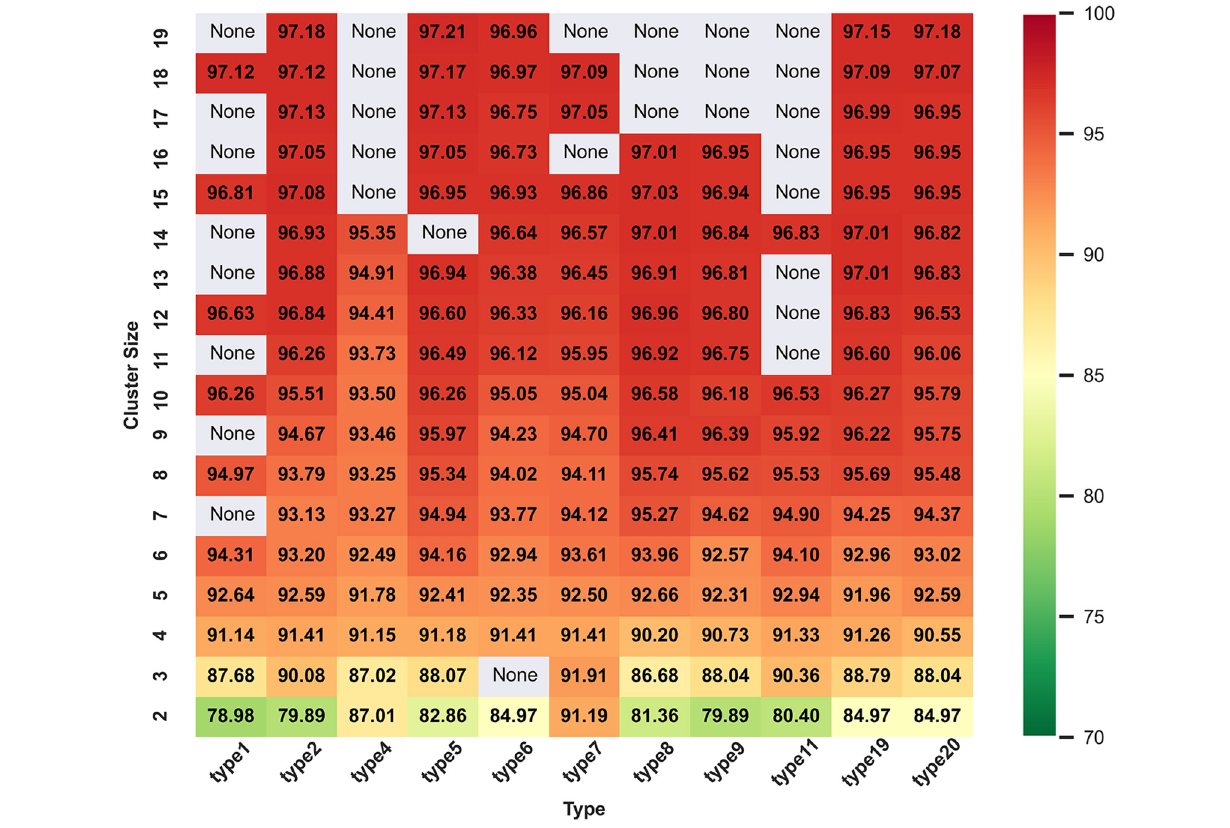
FIGURE 2 | Heat map of ACC values with reduced types from 1 to 20 and cluster size of 2 to 19 on training dataset in DS1. In general, the color gradient from green to red indicates the increasing trend of the values of ACC, and the areas with “None” indicate that there are no such reduction descriptors at the intersections of the corresponding reduction types and cluster